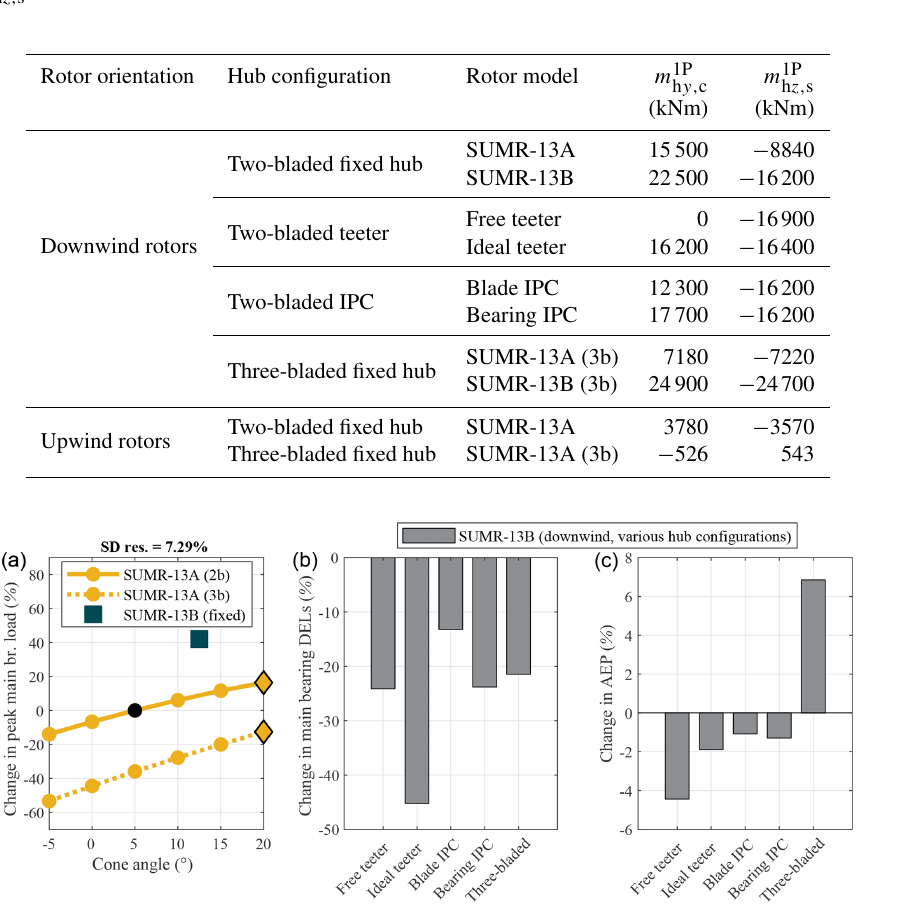
Table 5. Comparison of the 8.5ms − 1 hub load harmonics for two-bladed fixed, teeter, and IPC methods, as well as three-bladed (3b) rotors, in upwind and downwind positions. We analyze the cosine–cyclic hub load about the y h axis ( m 1P about the z h axis ( m 1P ) because of their combined effect on non-rotating component loads. The different teeter and IPC methods are h z, s presented in Sect. 9.2.